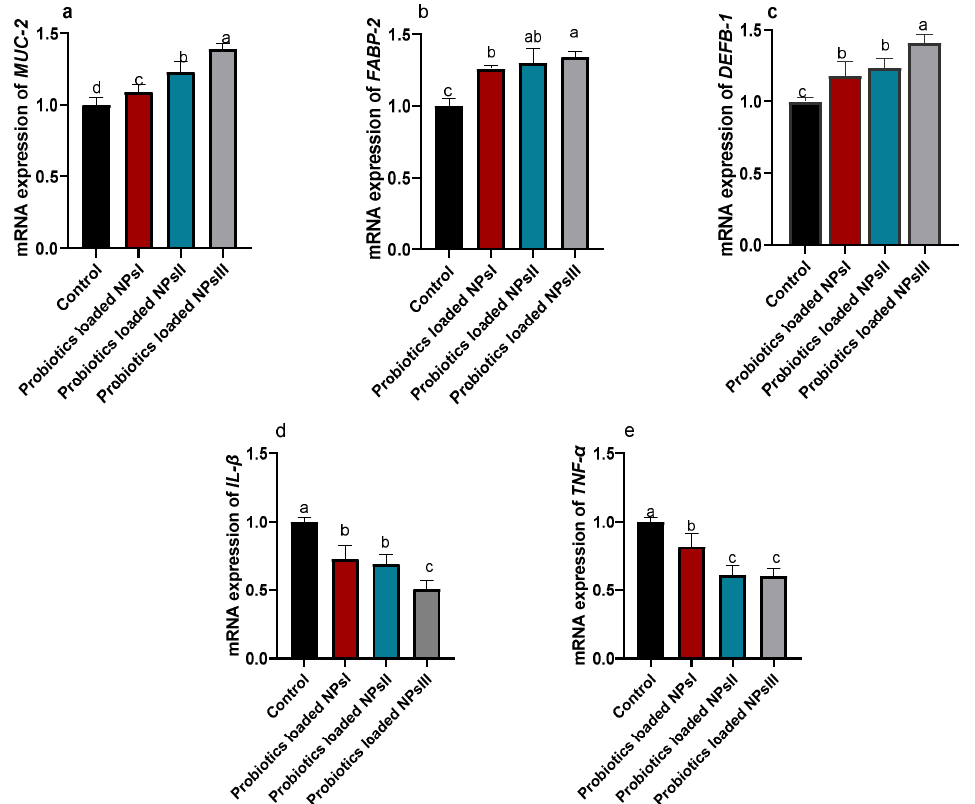
Figure 4. Effect of feeding Ross broilers ( n = 5/group) different levels of Bacillus amyloliquefaciens -encapsulated nanoparticles (BNPs I, II, and III) on the relative mRNA expression of mucin-2 ( MUC-2 , ( a )), fatty acid-binding protein-2 ( FABP-2 , ( b )), beta-defensin 1 ( DEFB-1 , ( c )), interleukin-1beta ( IL-1 β , ( d )), and tumor necrosis factor-alpha ( TNF- α , ( e )). The data represented the relative mRNA expression normalized to GAPDH and the significance is p < 0.05. a–d Mean values within columns showing numerous letters differ statistically.